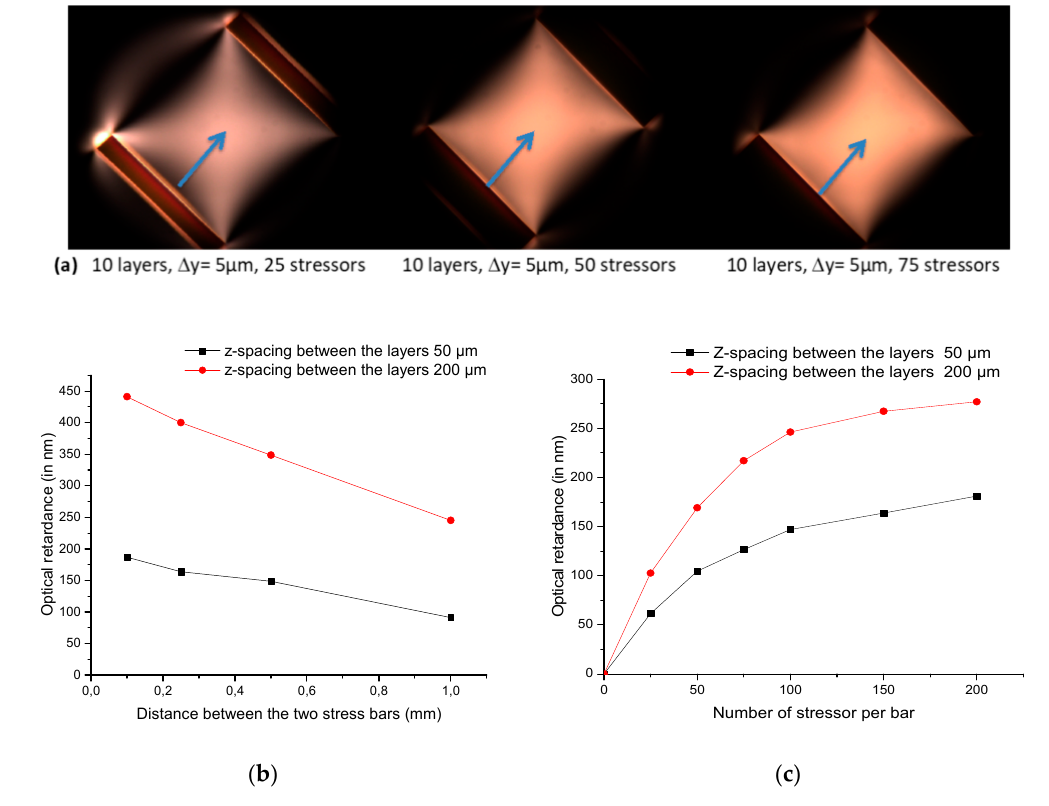
Figure 1. ( a ) Typical optical microscope images of stress-engineering waveplates taken between in crossed polarizers. Blue arrow indicates the center of the clear aperture. ( b ) Optical retardance R (in nm) as a function of the distance d (in mm) between the two stress bars (stressor gap 5 µm, 100 stressors per bar, 10 layers). ( c ) Optical retardance R measured at 550nm as a function of the number of stressors per bar. The clear aperture was fixed to 1 mm. Conditions: SuprasilCG glass, λ = 1030 nm; 250 fs; 100 kHz; 1 mm/s scanning speed; numerical aperture 0.16 NA; 2 µJ/pulse .